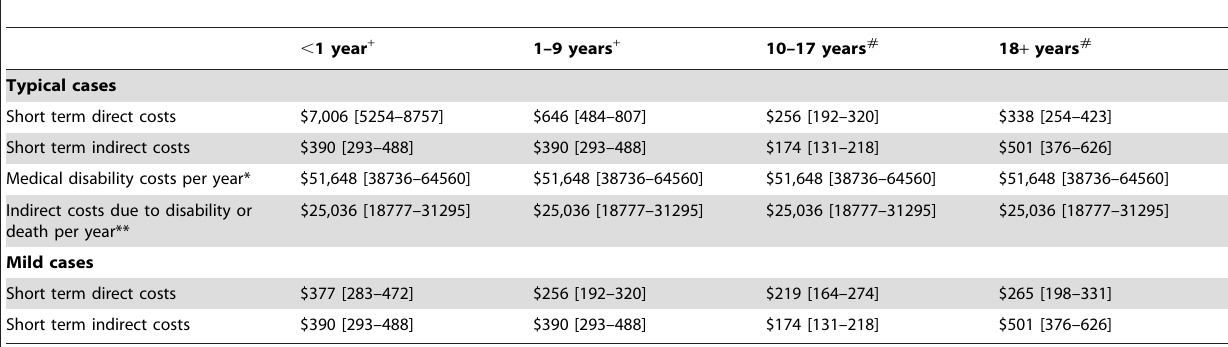
Table 3. Estimates for the short term cost per case of pertussis infection (ranges used in sensitivity analyzes presented in